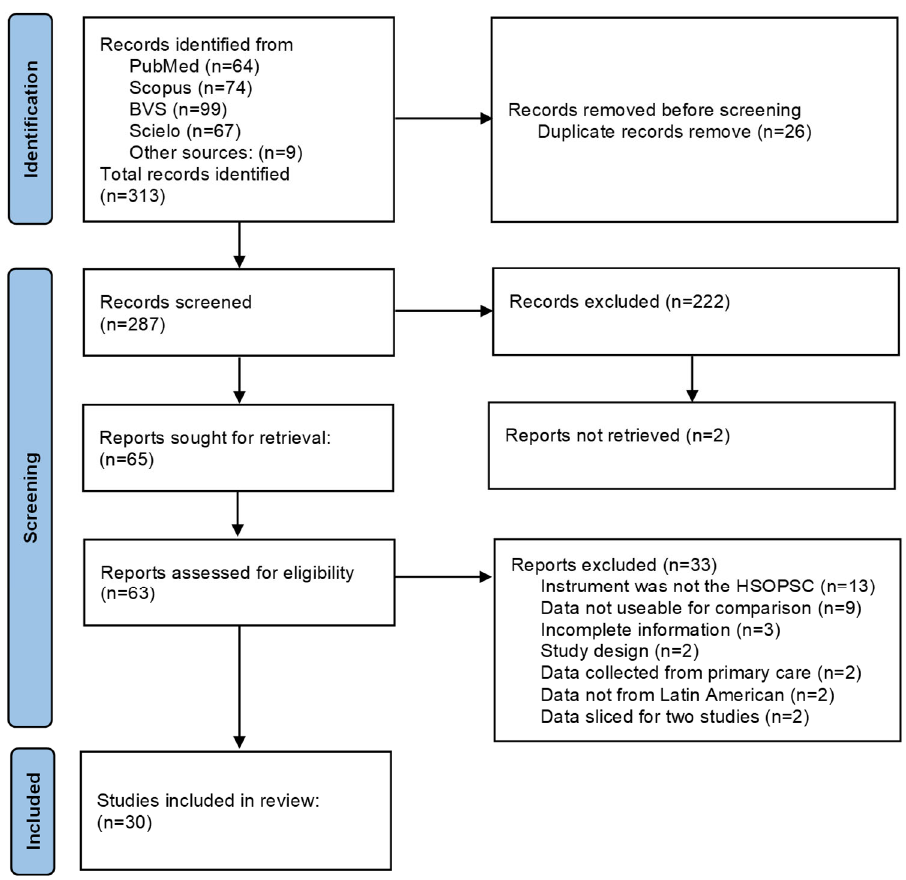
Figure 1. PRISMA 2020 flow diagram for systematic reviews.